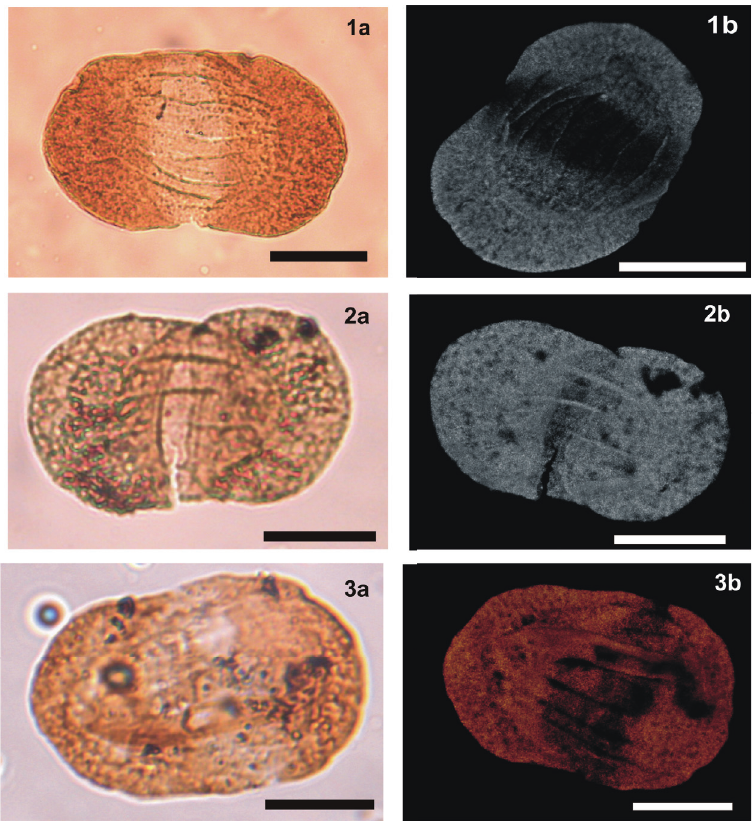
Figure 7. Specimens compared under OM and CLSM. Scale bar = 20